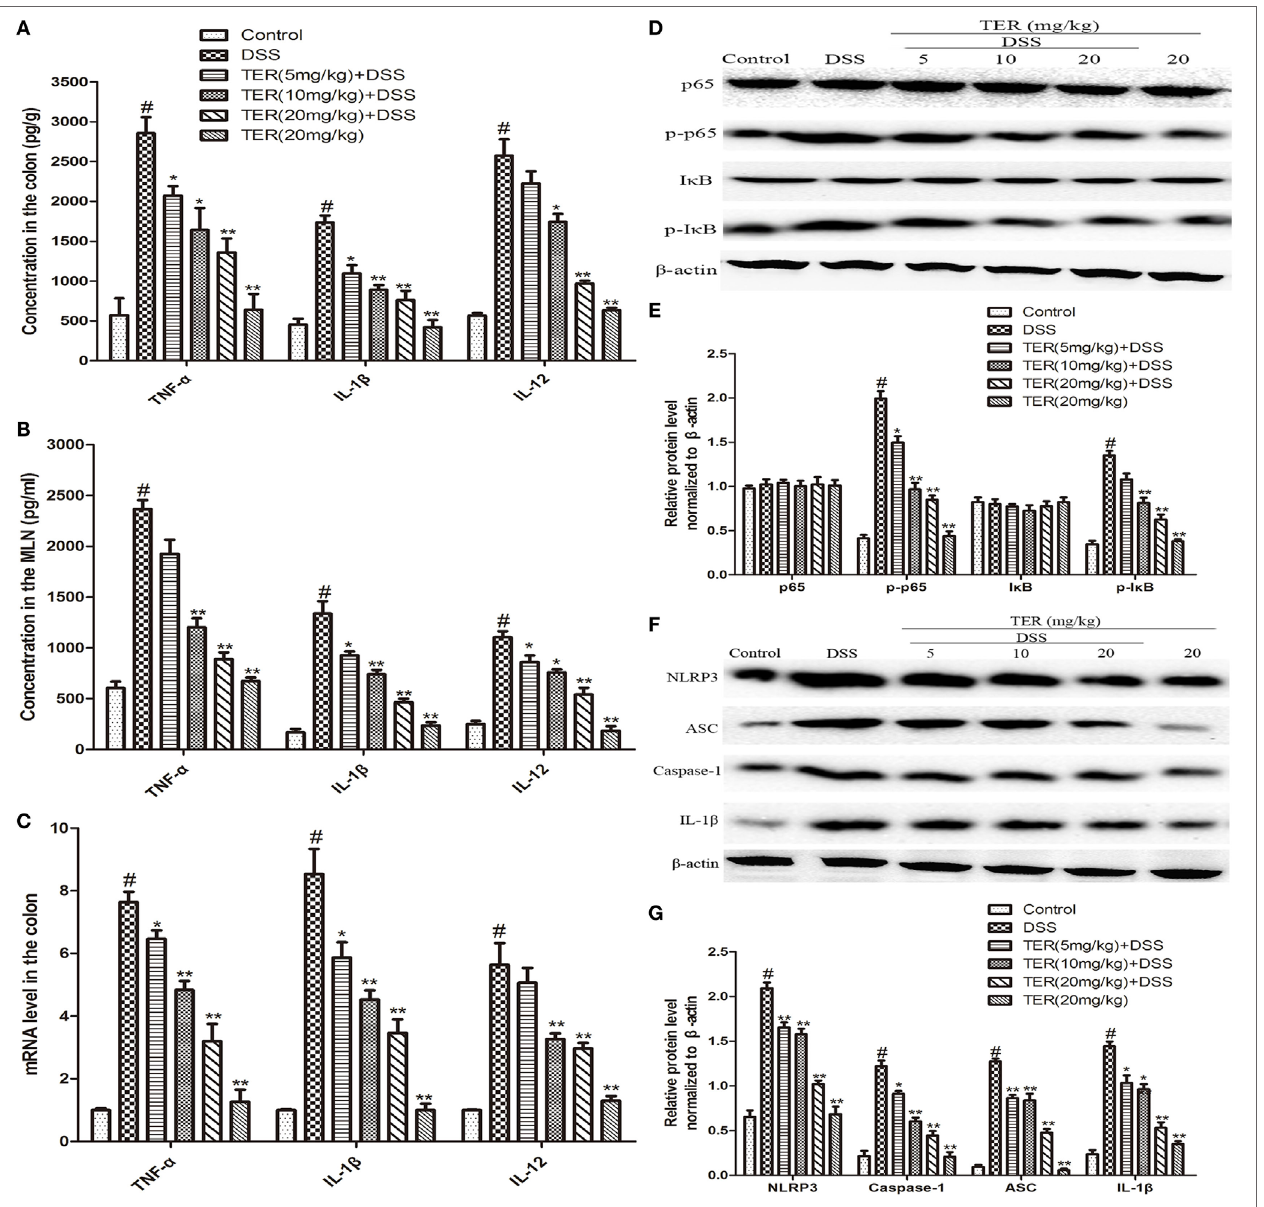
FigUre 2 | Terpinen-4-ol (Ter) reduces pro-inflammatory cytokines secretion and suppresses nF- κ B and nlrP3 inflammasome activation in dextran sulfate sodium (Dss)-treated c57Bl/6 Mice . (a) The production of inflammation-related cytokines tumor necrosis factor α (TNF- α ), interleukin-1 β (IL-1 β ), and interleukin-12 (IL-12) in colonic cultures. (B) The production of inflammation-related cytokines TNF- α , IL-1 β , and IL-12 in mesenteric lymph node stimulated with cecal bacterial lysates. (c) TNF- α , IL-1 β , and IL-12 mRNA levels in the colon tissues were measured by quantitative real-time PCR. (D,F) Protein levels of NF- κ B p65, I κ B, NLRP3, ASC, caspase-1, and IL-1 β in the colon tissues were analyzed by western blotting. (e,g) The relative protein expression of NF- κ B p65, I κ B, NLRP3, ASC, caspase-1, and IL-1 β were normalized to β -actin. The results are representative of at least three independent experiments and expressed as mean ± SD. * p < 0.05 and ** p < 0.01 vs the group treated with only DSS; # p < 0.05 vs the control